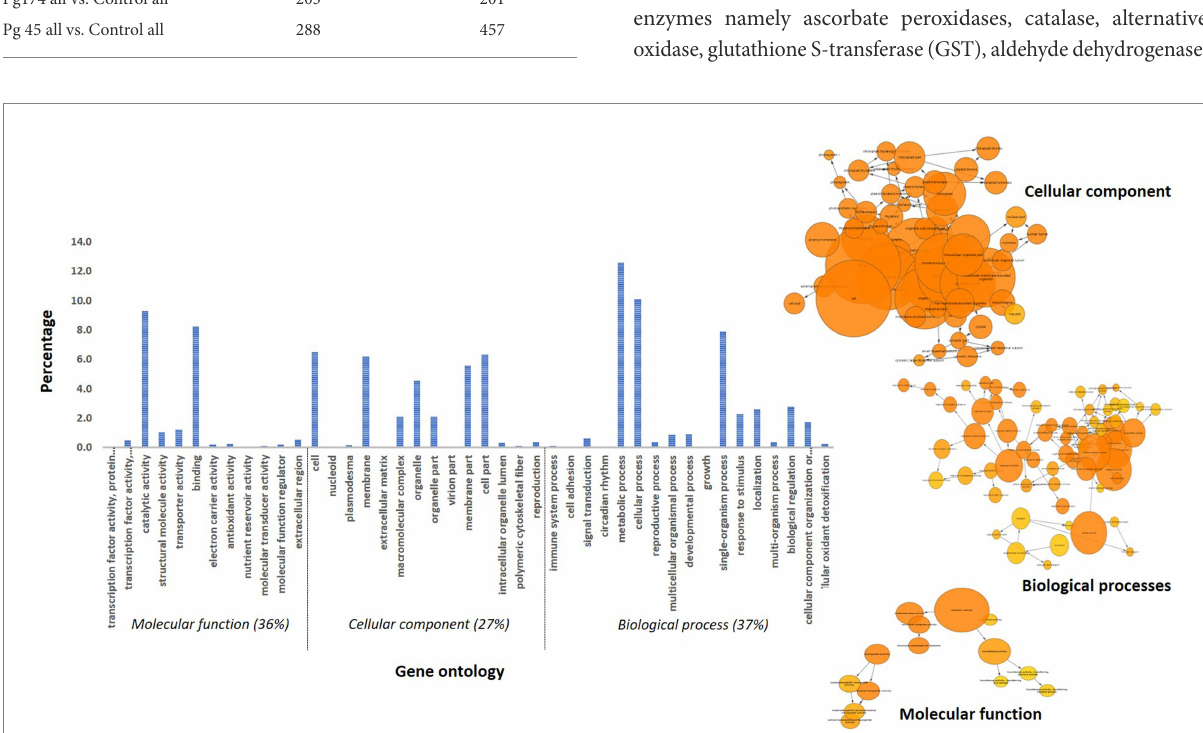
FIGURE 2 Gene ontology distribution of pearl millet transcripts and BINGO network categorized in cellular component, molecular function and biological